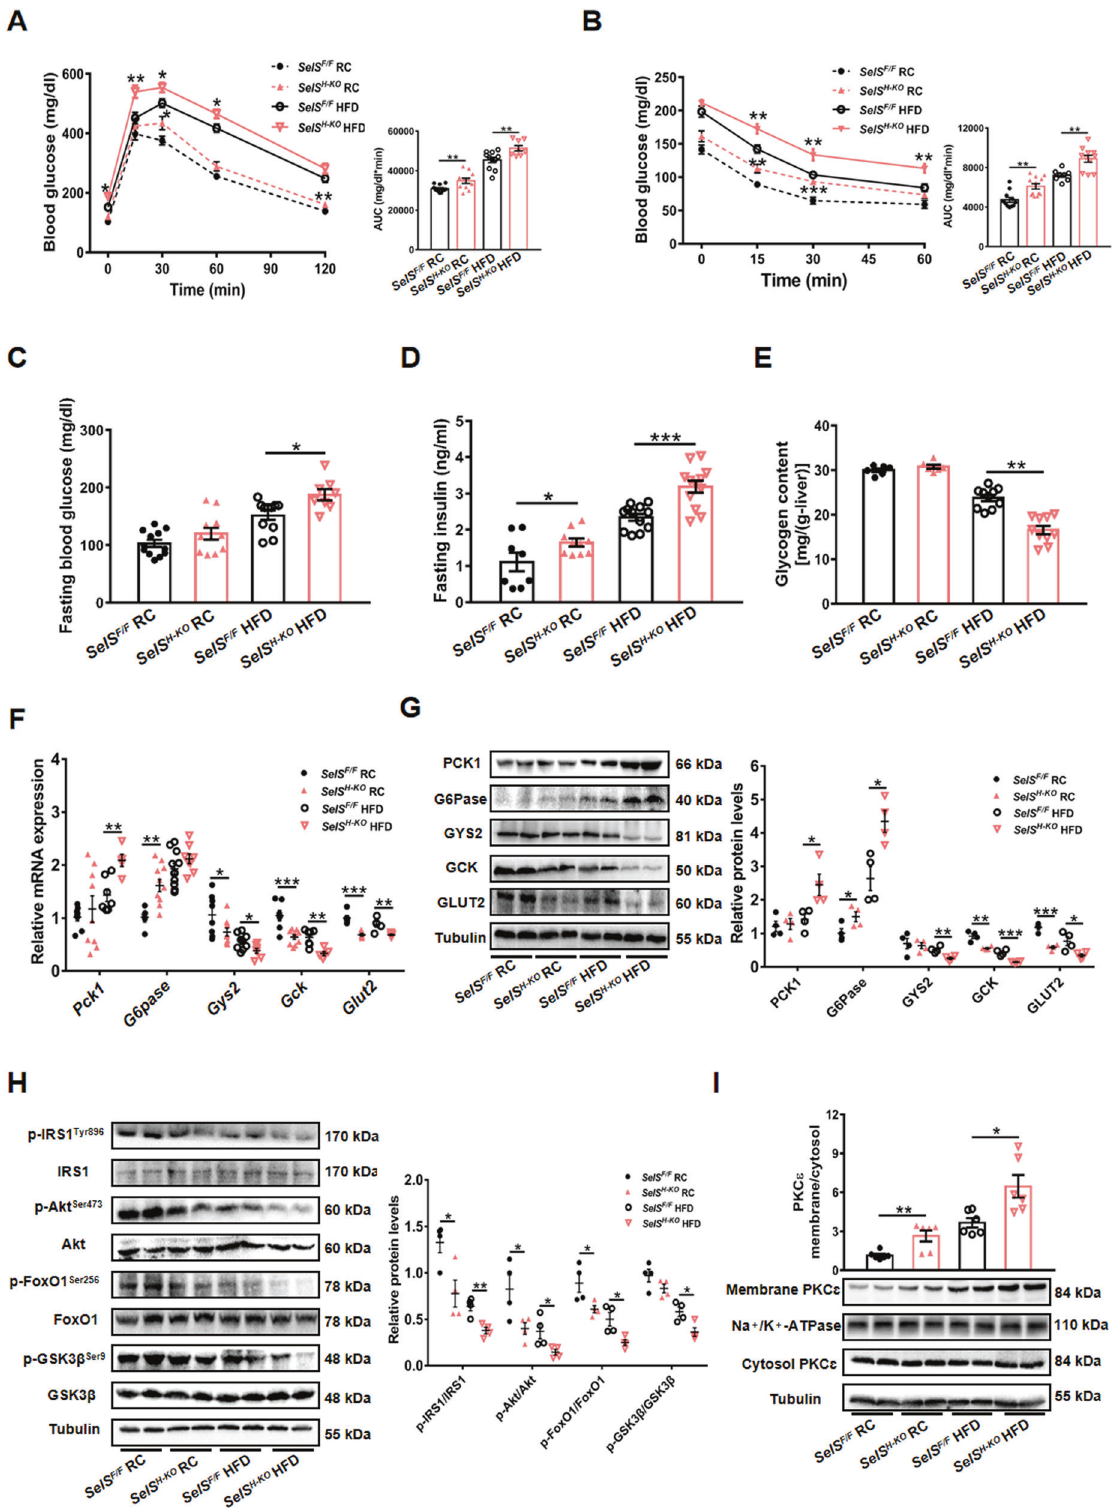
steps of glycolysis and hepatic glycogen synthesis [31]. Glucose transporter 2 (GLUT2) is responsible for glucose uptake into hepatocytes [32]. SelS H-KO mice showed notably lower expres- sion levels of GCK and GLUT2 under the same dietary conditions ( P < 0.05; Fig. 4F and